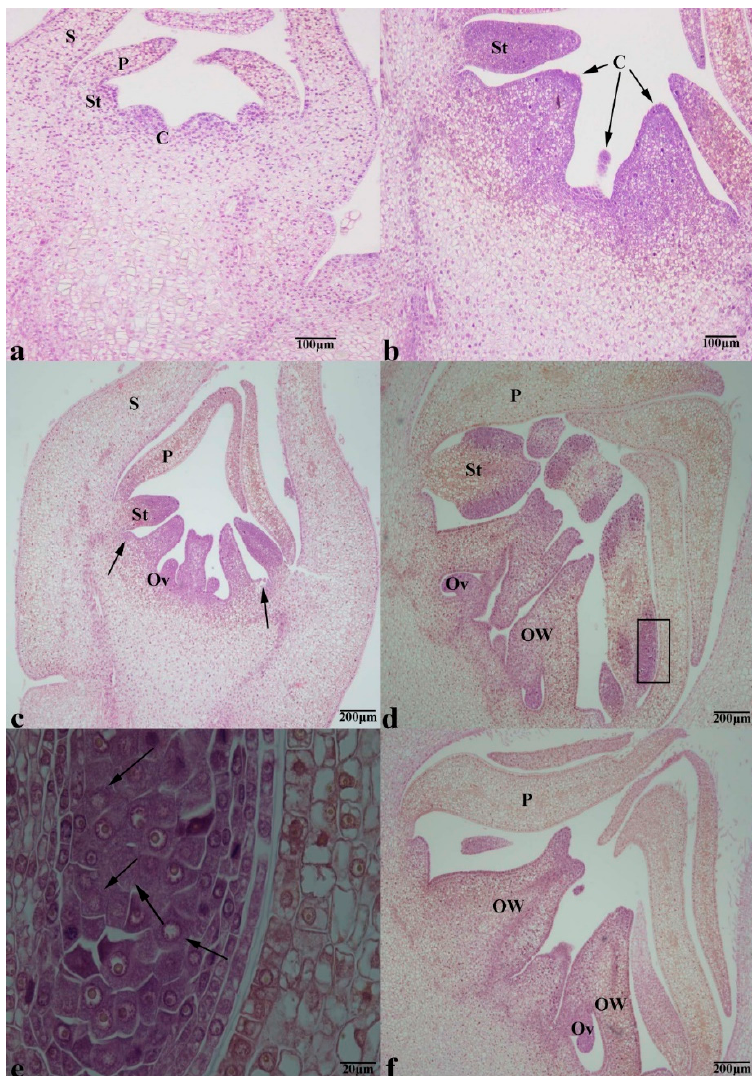
Figure 4. H&E staining of female floral buds during differentiation in persimmon. ( a ) Details of the carpel primordium harvested on April 5, 2017. ( b ) Further differentiation of the carpel primordium harvested on April 8, 2017. ( c ) Sample at the ovule primordium differentiation stage (arrows indicate nectary tissues) harvested on April 11, 2017. ( d ) Details of the integuments and macrosporocyte harvested on April 14, 2017. ( e ) Image of the stamen from the rectangle magnified in ( d ) (arrows indicate dead cells). ( f ) Details of the female floral bud harvested on April 17, 2017. (C = carpel; Ov = ovule; OW = ovary wall; P = petal; S = sepal; St = stamen).